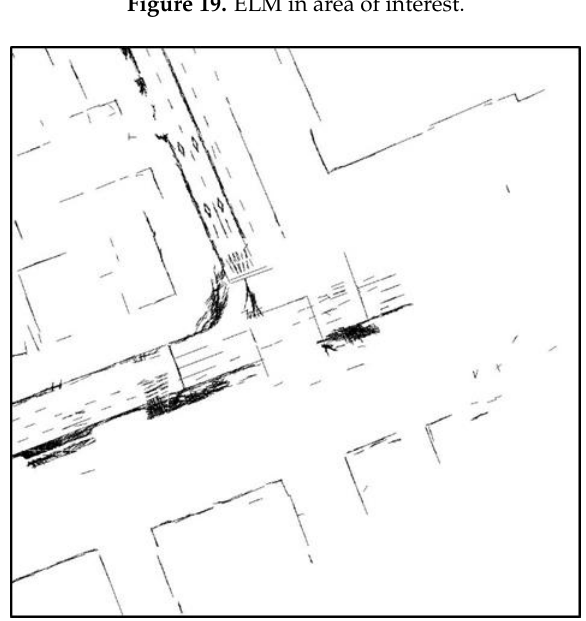
Figure 20. Result of converting Figure 19 into occupancy grid map.